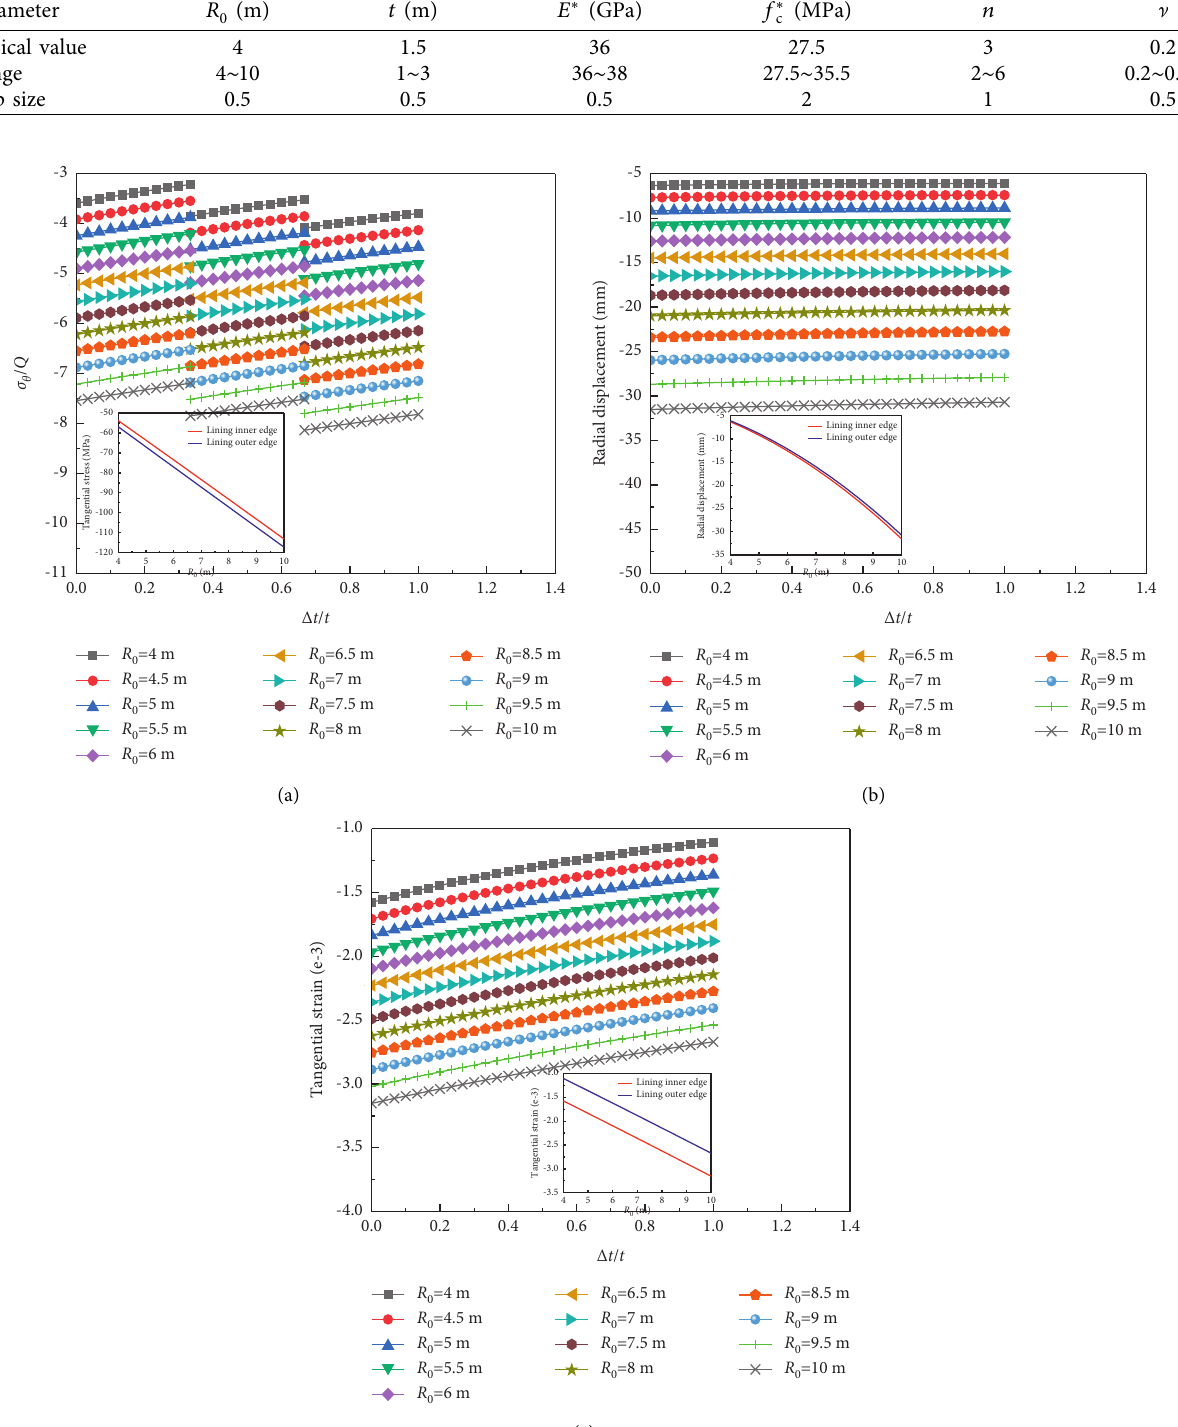
Figure 3: Variations in tangential stress, radial displacement, and tangential strain of FGL with internal radius R stress. (b) Radial displacement. (c) Tangential